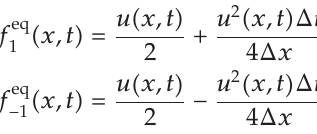
Figure 1: D1Q2 model with two velocities in one